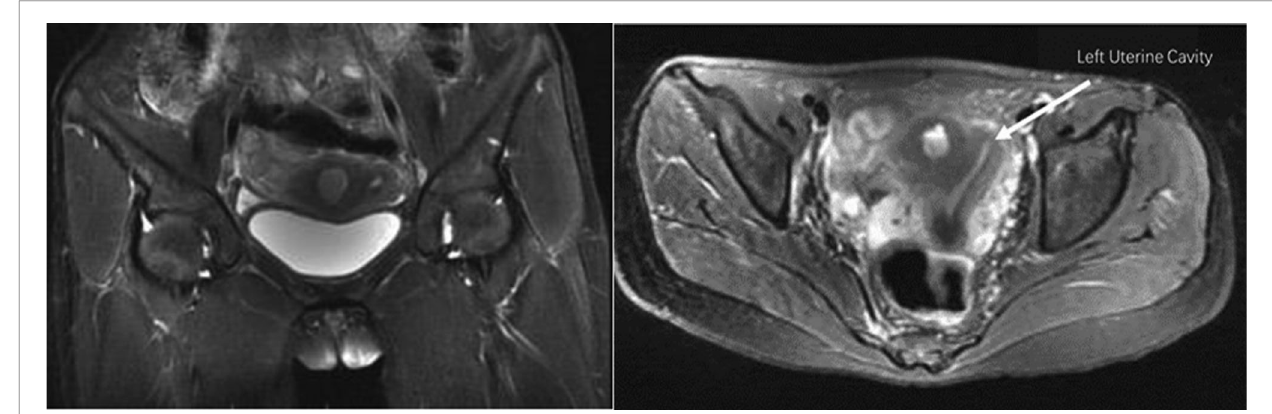
FIGURE 1 | Preoperative pelvic magnetic resonance images.